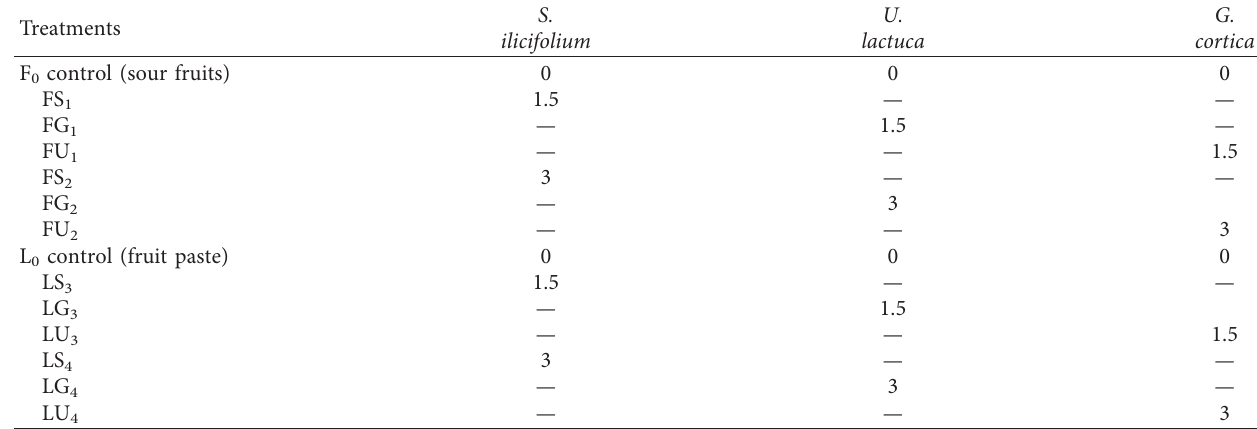
Table 2: The studied treatments [16].